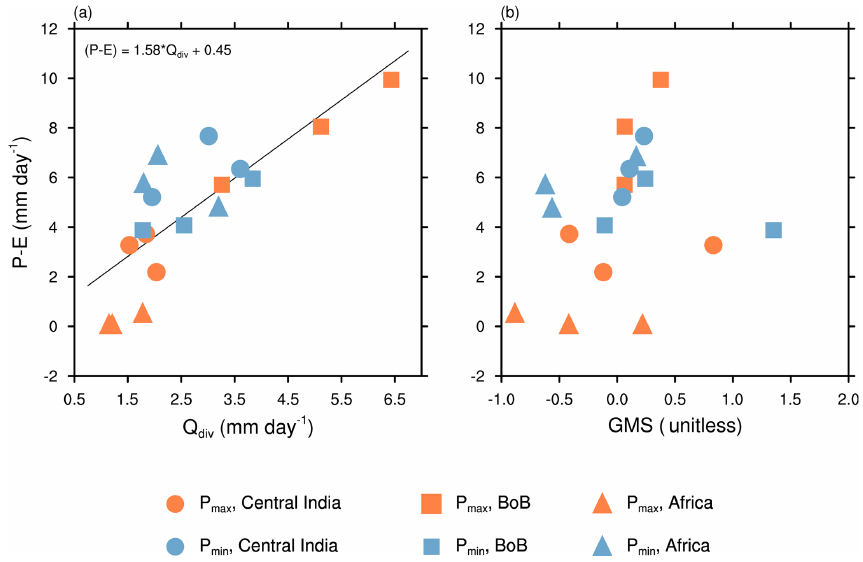
Figure 3. The dependence of P − E on (a) Q div and (b) GMS, for three regions: central India (15–25 ◦ N; 73–83 ◦ E), the Bay of Bengal (10–20 ◦ N; 85–95 ◦ E), and Africa (5–15 ◦ N; 20 ◦ W–0 ◦ E). The months Jun–Jul–Aug are taken separately. The blue and orange symbols correspond to P min and P max ,